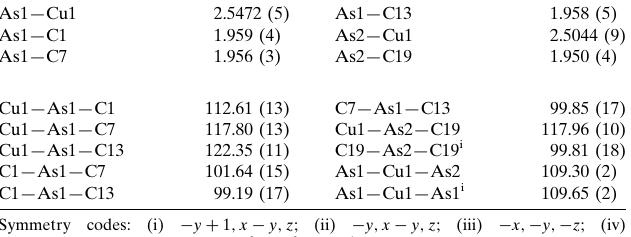
Selected geometric parameters (A˚ , (cid:3)